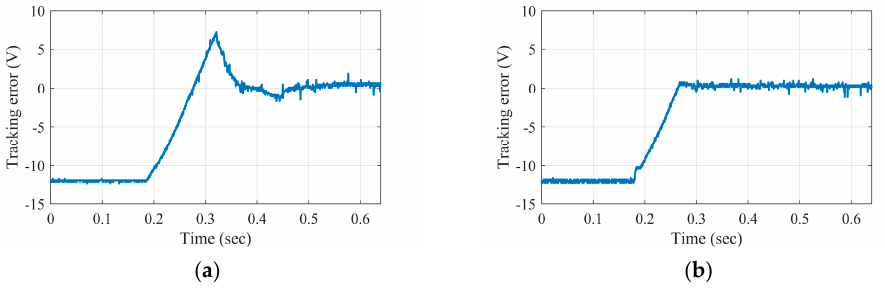
Figure 6. Tracking performance in Case 1 with DC motor load, ( a ) PI control, ( b ) FTSM-ELM control.